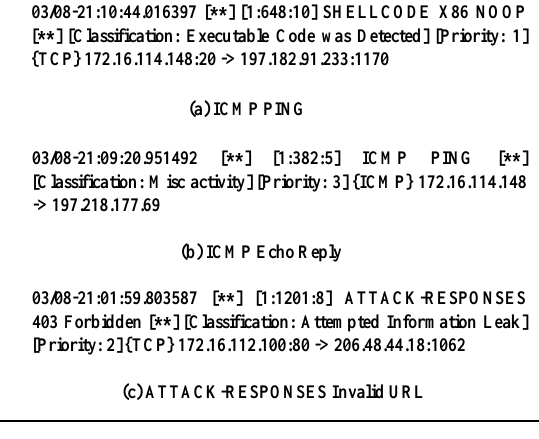
Figure 1. Generic rule format in Snort with two examples.